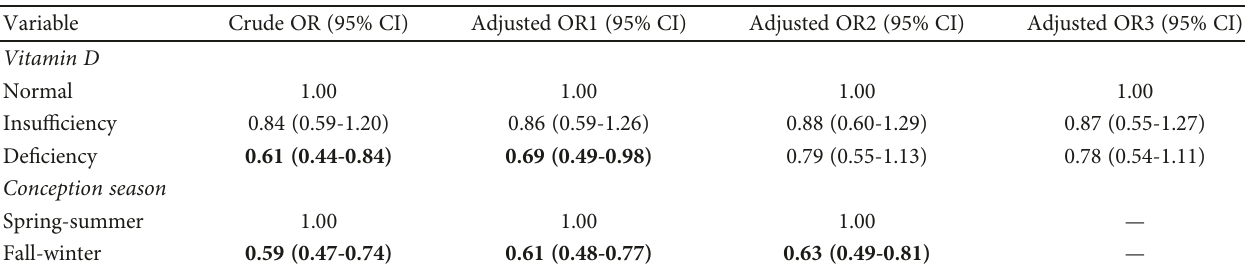
Adjusted OR1 for vitamin D is adjusted for age, prepregnancy BMI, family history of diabetes, parity, smoking, drinking, gestational week of blood withdrawn, income, and education; adjusted OR1 for conception season is adjusted for age, prepregnancy BMI, family history of diabetes, parity, smoking, drinking, income, and education; adjusted OR2 for vitamin D is adjusted OR1 plus adjusting for conception season (as four categories); adjusted OR2 for conception season was adjusted OR1 plus adjusting for vitamin D (as three categories). Adjusted OR3 is adjusted OR1 plus the season of the blood draw (as four categories) in the fi rst trimester. Abbreviations: BMI: body mass index; OR: odds ratio; CI: con fi dence